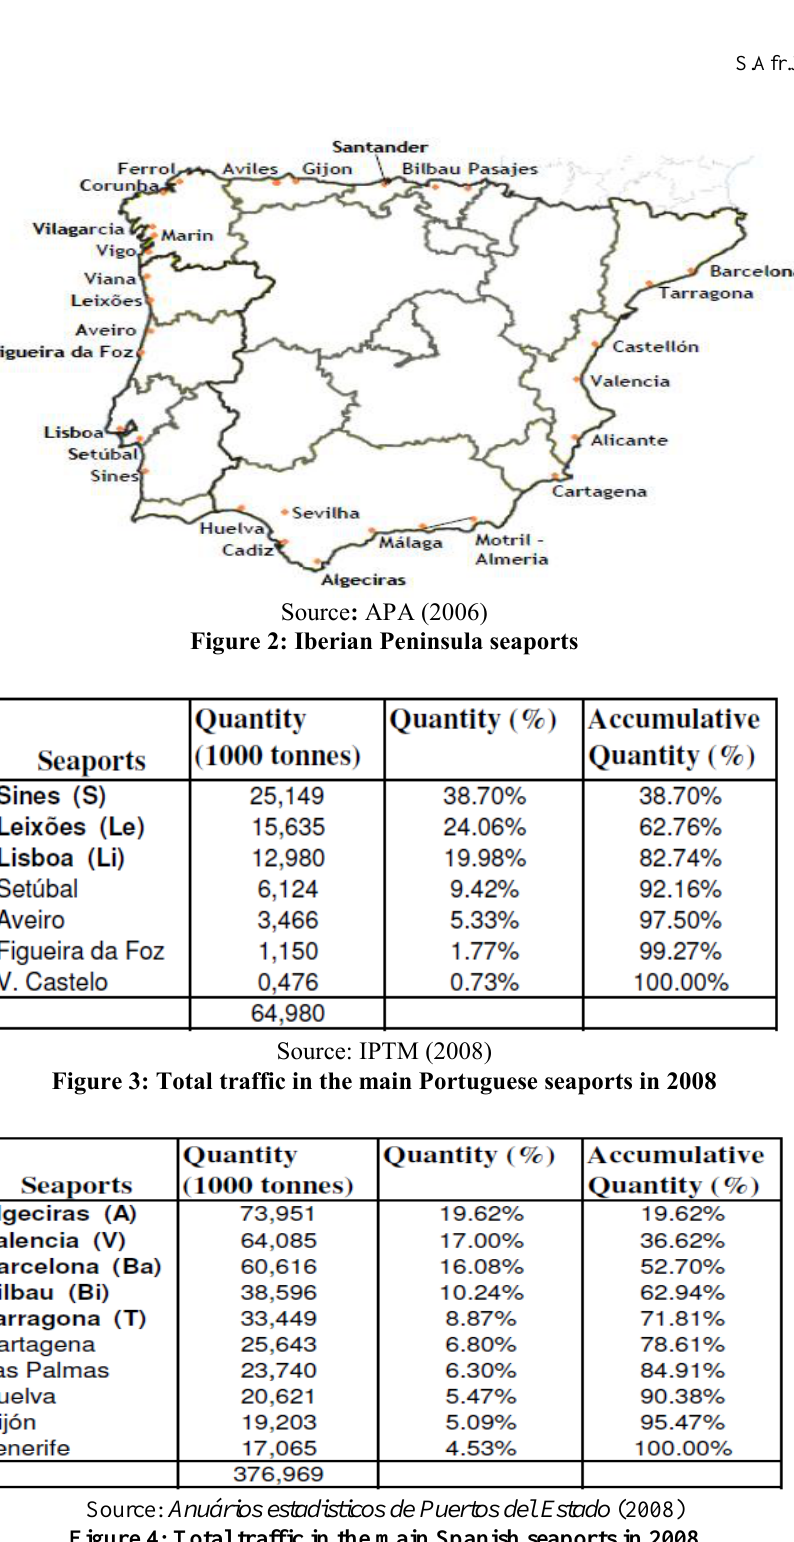
Figure 4: Total traffic in the main Spanish seaports in